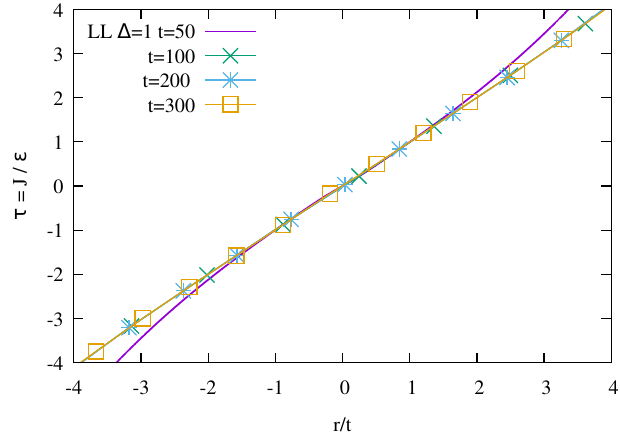
Figure 18: LL torsion τ plotted as a function of r / t . The good data collapse shows that, at long times, one simply has τ = r / t